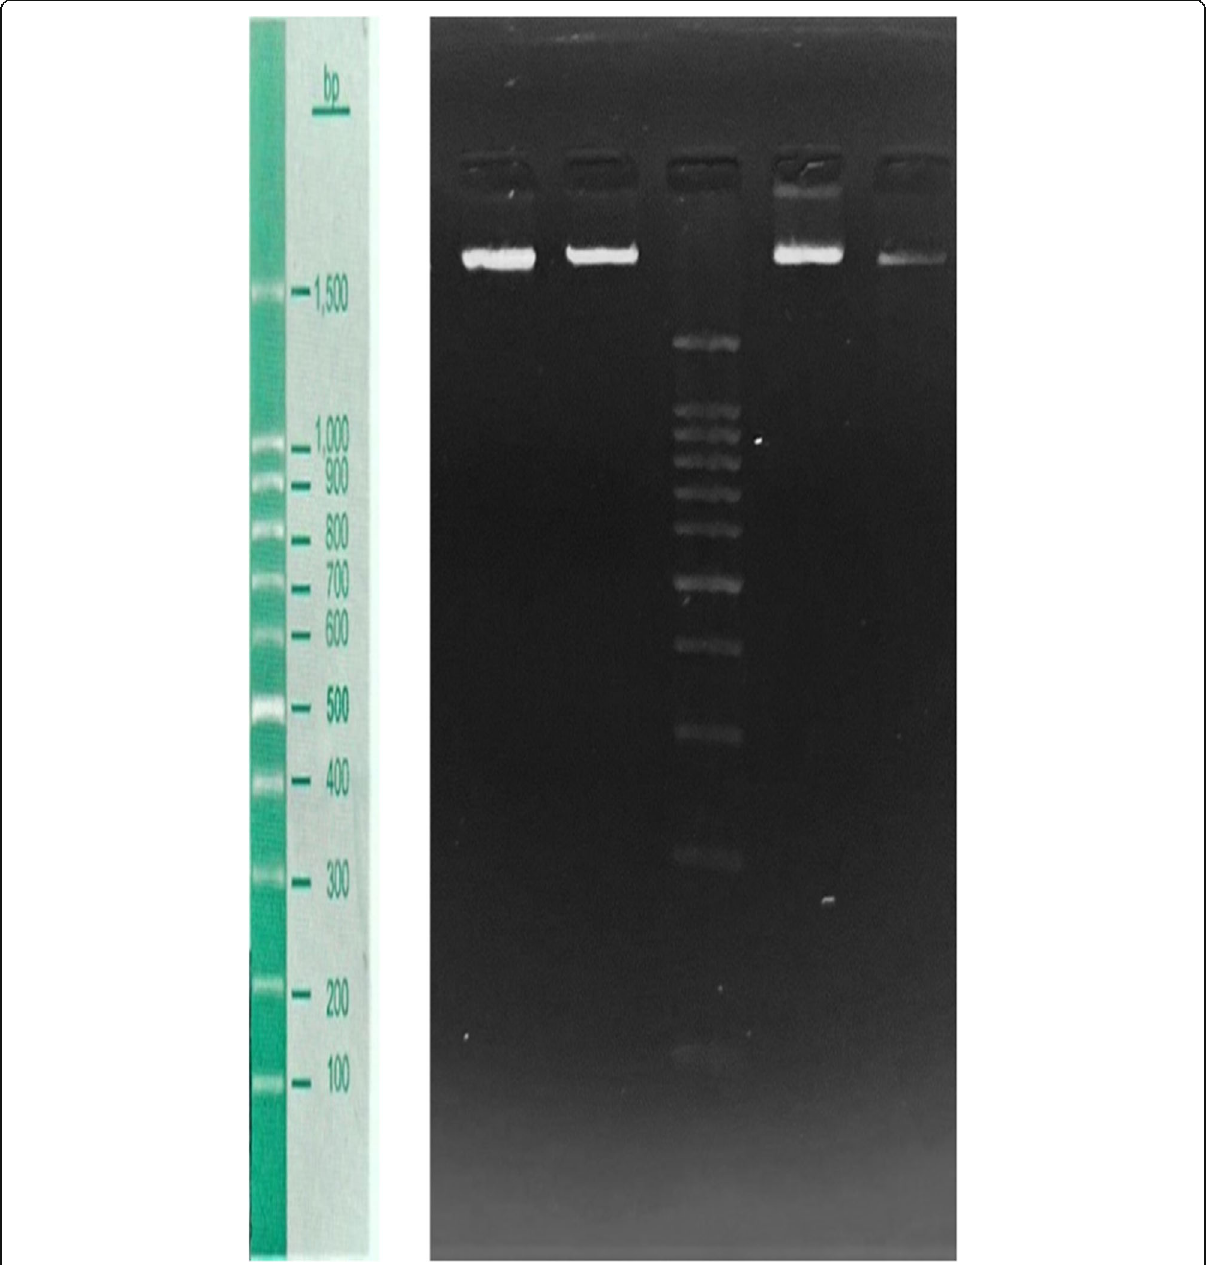
Fig. 6 DNA fragmentation test. Effect of Ag NPs on genomic DNA of MCF-7 and Vero cell lines. MCF-7 and Vero cell were seeded for 24 h and then treated with Ag NPs for 48 h or left without treatment as control. gDNA was extracted and electrophoresed at voltage of 75 for 1 h in %1.5 agarose. The bands were visualized under UV light. Left to right direction; lane 1: Ag NPs (100 μ g/ml) Vero-treated samples; lane 2 DMSO Vero- treated sample; lane 3 1500 bp DNA ladder; lane 4 MCF-7 DMSO-treated samples; lane 5 Ag NPs (100 μ g/ml) MCF-7-treated